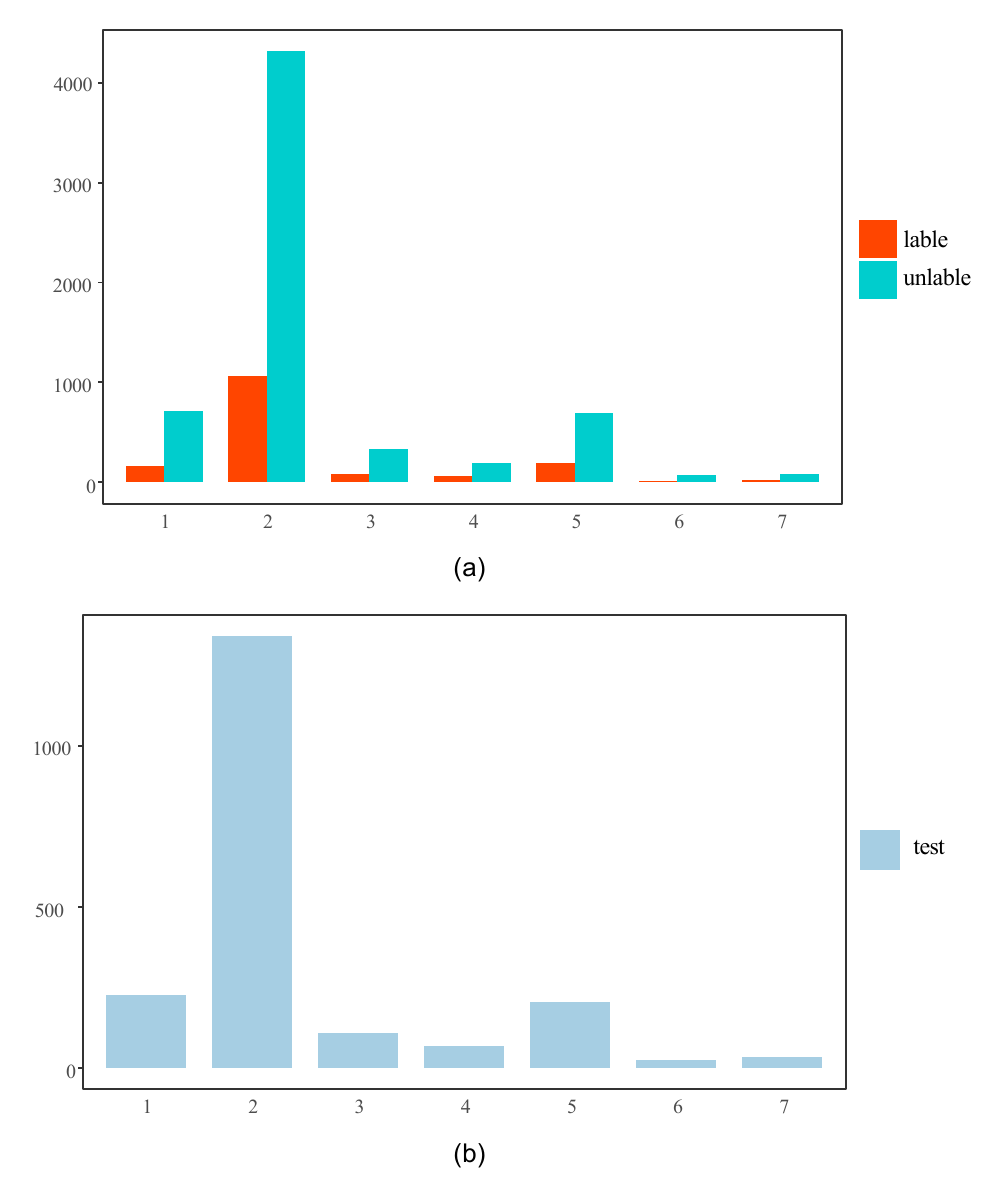
Figure 1. ( a ) The distribution of samples with labels in the central server is shown in red, and the distribution of samples without labels in the local client is shown in green. ( b ) Sample distribution of test set categories for model detection.